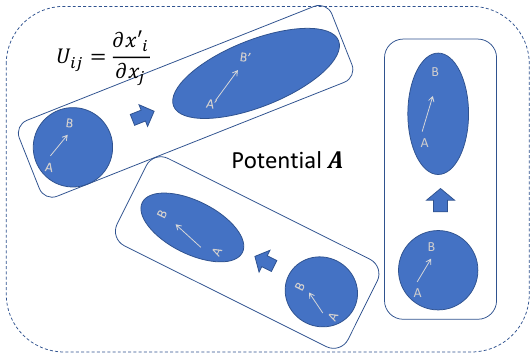
Figure 1. Concept underlying present field theory. Potential associated with connection field logically connects local elastic